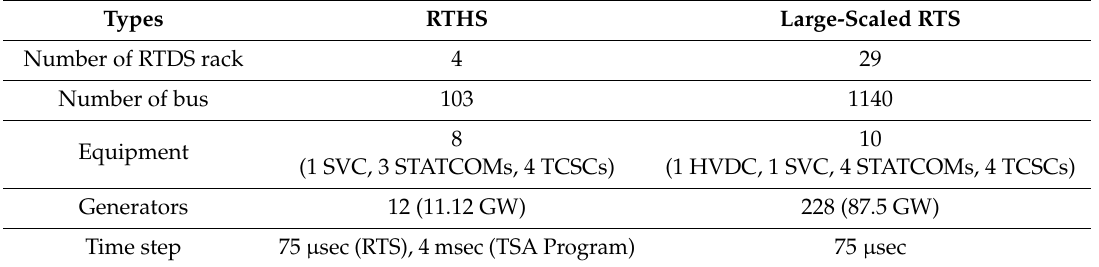
Table 3. Simulation environment details of RTHS and the large-scaled RTS for Shin-Jecheon SVC